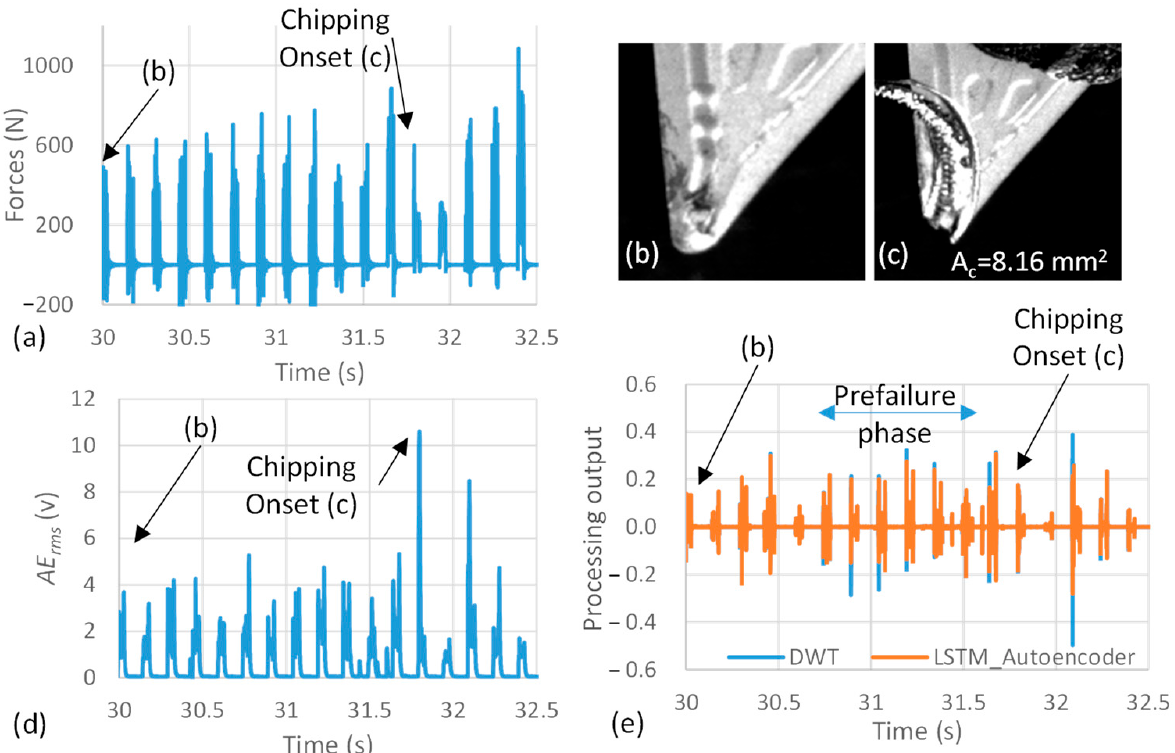
Figure 4. ( a ) Raw cutting force signals, ( b , c ) high-speed camera photos, ( d , e ) the raw and processed AE rms signal of Test 3 at tool failure.